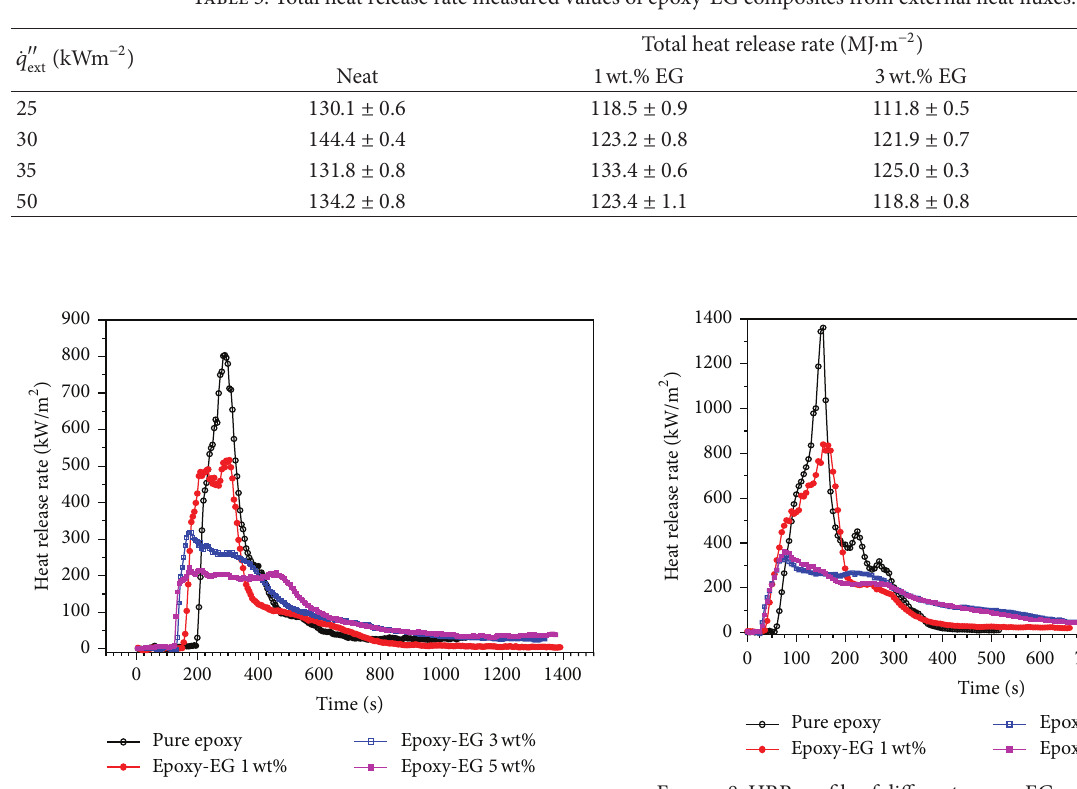
Figure 8: HRR profile of different epoxy-EG compositions at exter- nal heat flux of 50 kWm −2